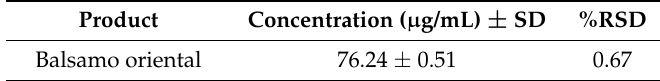
Table 3. Concentration of vanillyl butyl ether in commercial cosmetic